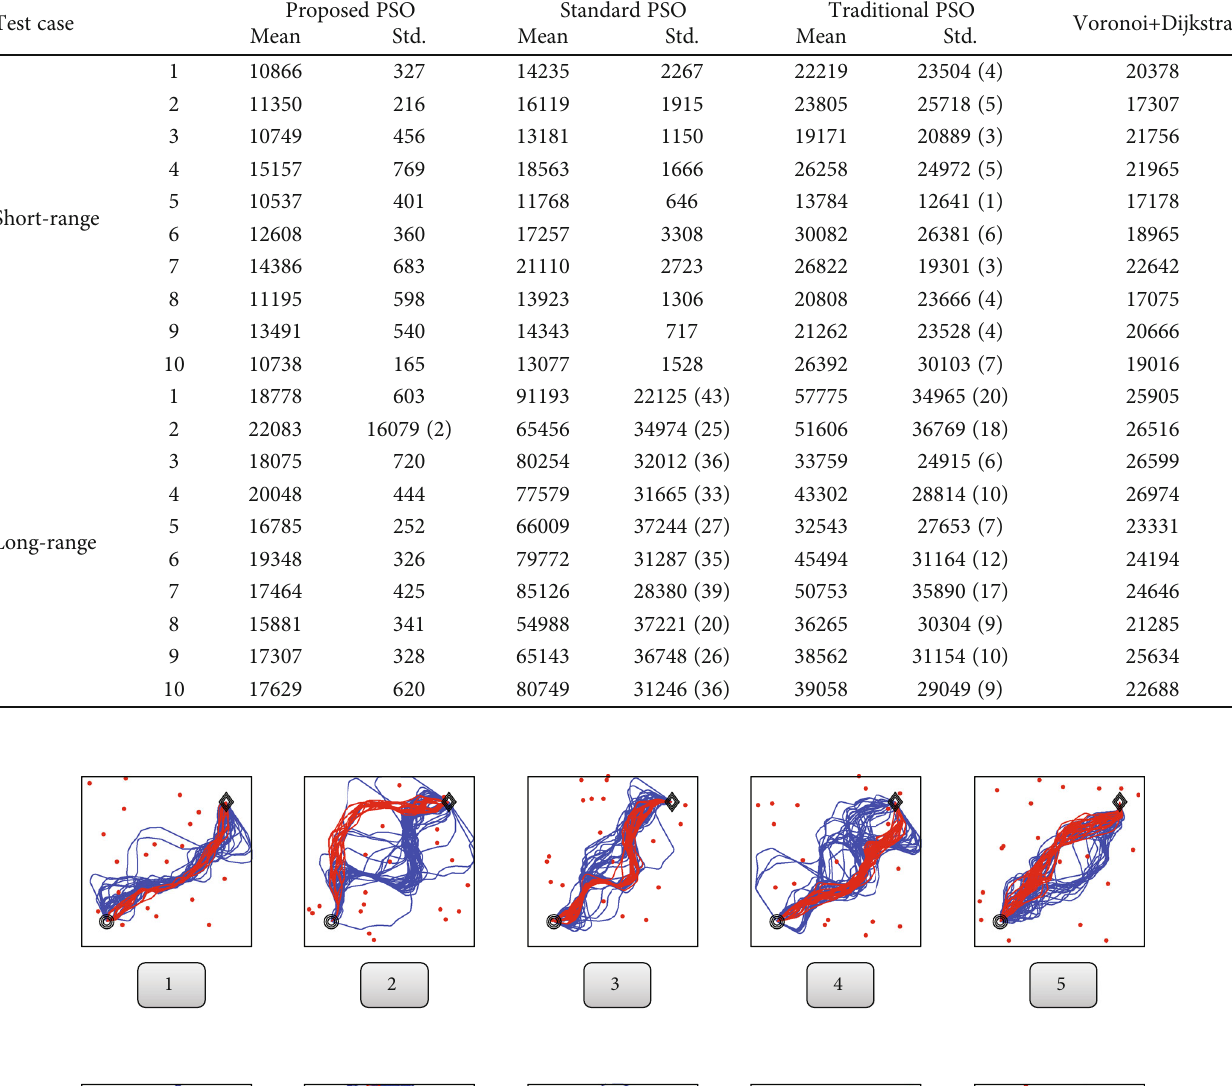
Table 5: Mean costs and standard deviations for 20 test cases with 50 Monte Carlo simulations.